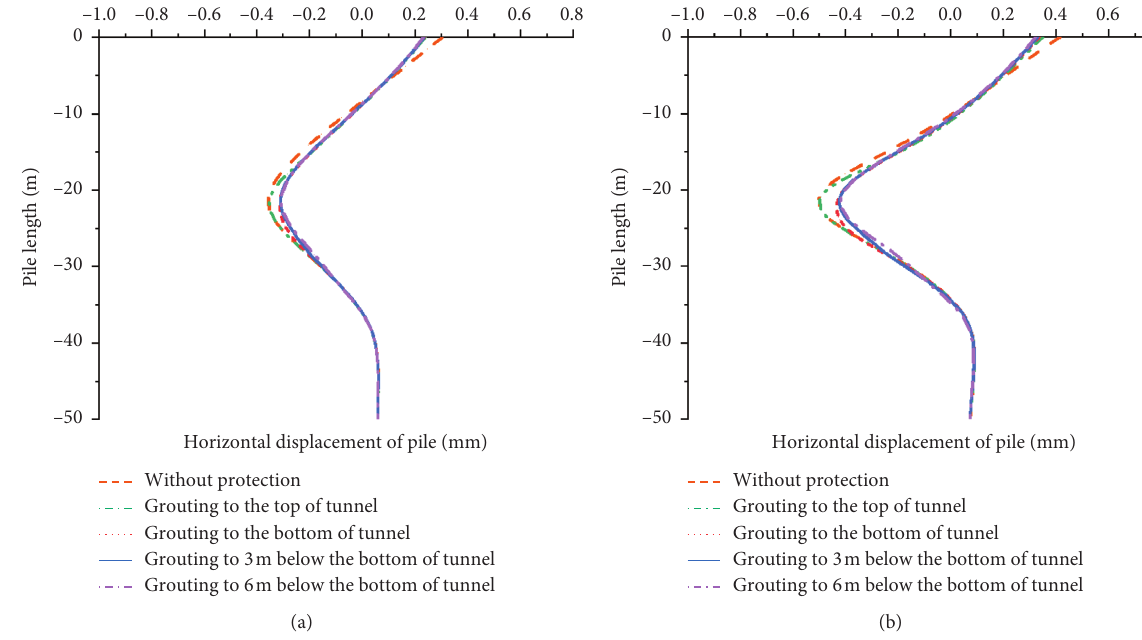
Figure 10: Horizontal displacement of the pile: (a) 6 rings before arriving at the pile; (b) 4 rings before arriving at the pile.